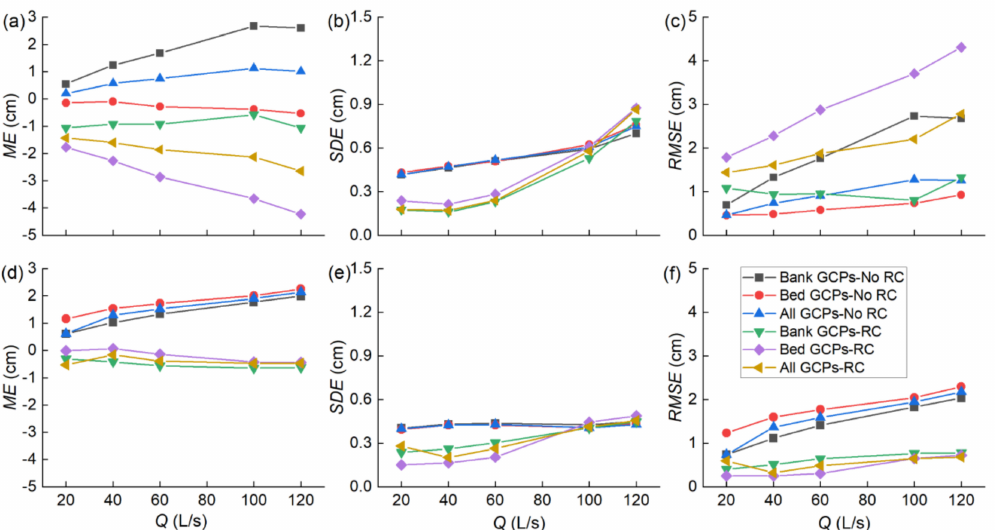
Figure 4. Error statistics for the submerged models with/without refraction correction (RC) for MR1 ( a – c ) and MR2 ( d – f ). Mean error ( ME ) is an indicator for accuracy; standard deviation ( SDE ) is an indicator for precision; and root mean square error ( RMSE ) illustrates deviation from the dry bed surface. All the statistics were calculated based on the DoDs between the submerged models and dry